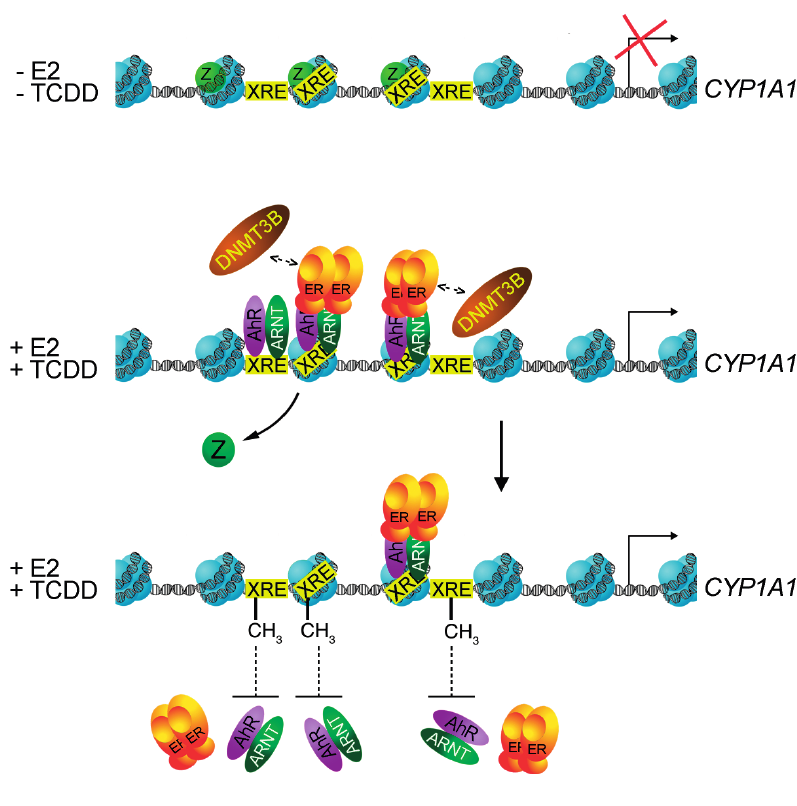
of estradiol and 2,3,7,8-tetrachlorodibenzo- p -dioxin (TCDD), CYP1A1 is not expressed and H2A.Z is present in its promoter. In the presence of both ligands, H2A.Z is removed and AhR/Arnt/ER α is recruited to the CYP1A1 promoter. ER α displaces AhR/Arnt by promoting DNA methylation on the XREs in the CYP1A1 promoter, thus resulting in less AhR activating surfaces available to stimulate CYP1A1 expression than in presence of TCDD